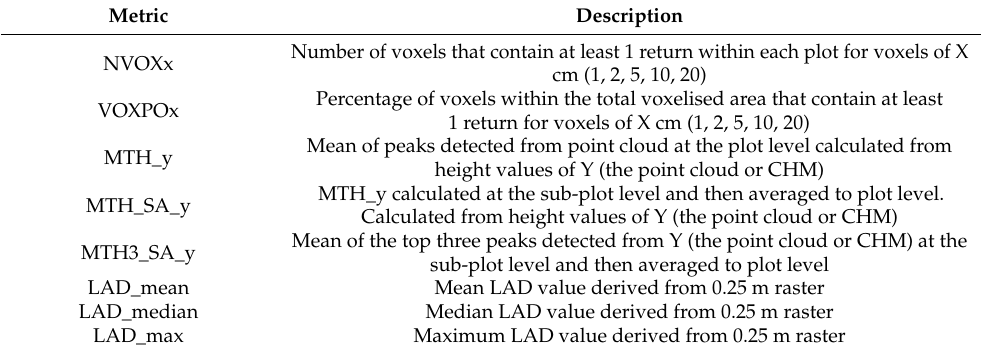
Table 3. Cont. Metric